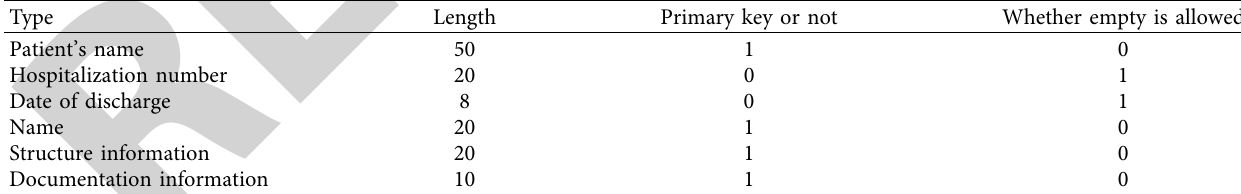
Table 2: Electronic medical record document information